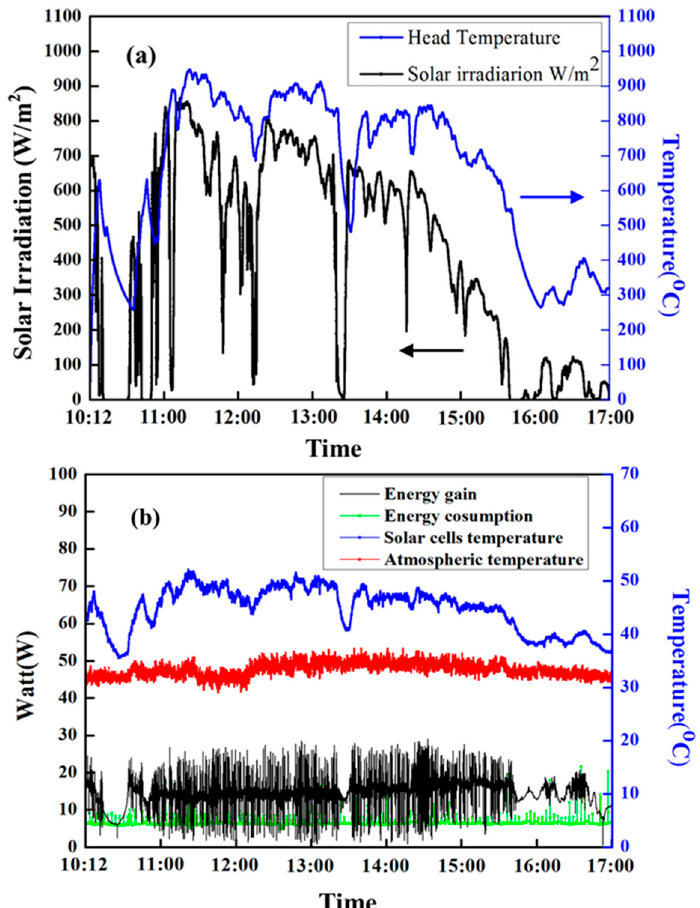
Figure 5. ( a ) the temperature profile of the heating head and solar irradiation and ( b ) the energy gain energy consumption, solar cells temperature and atmosphere temperature at June 22, 2013.